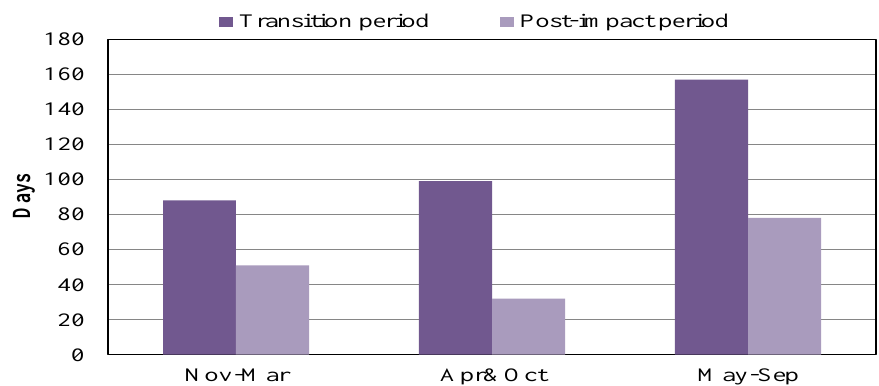
Figure 12. The number of days of low-standard streamflow in different months between the transition and post-impact periods. The standard streamflow from November to March is 530 m 3 / s. The standard streamflow in April and October is 600 m 3 / s. The standard streamflow from May to September is 800 m 3 /s.